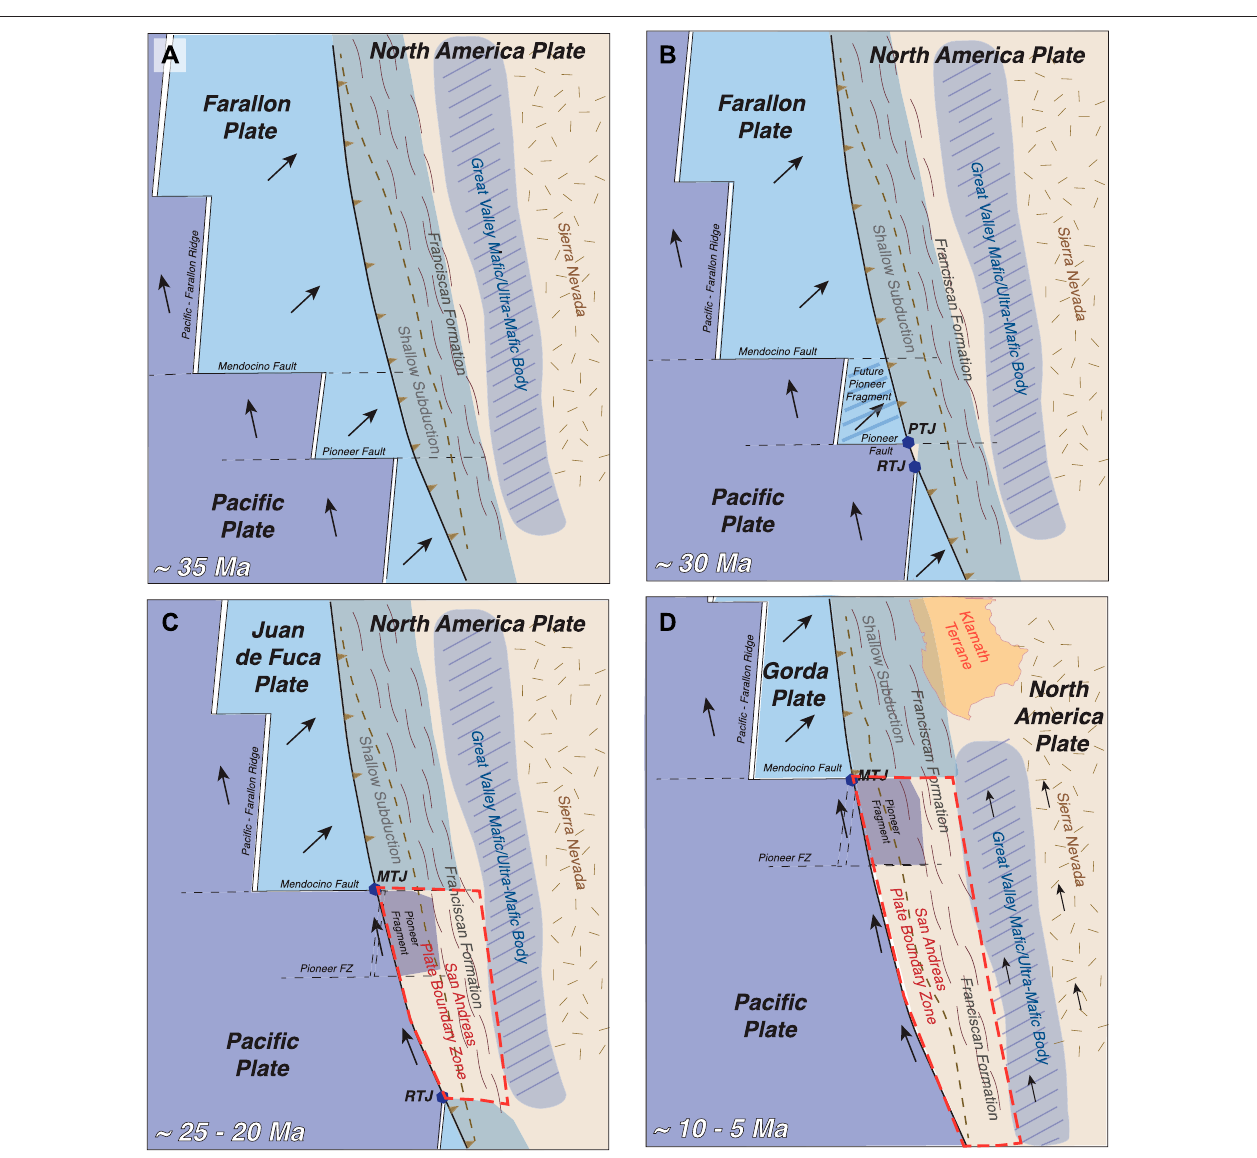
FIGURE3| Schematicplatereconstructionoftheregionfrom~35 Ma – 5 Ma.Thelocationsofkeygeologicalandtectonicterranesarehighlighted. (A) ~35 Ma, (B) ~30 Ma, (C) ~25 – 20 Ma, (D) ~10 – 5 Ma.